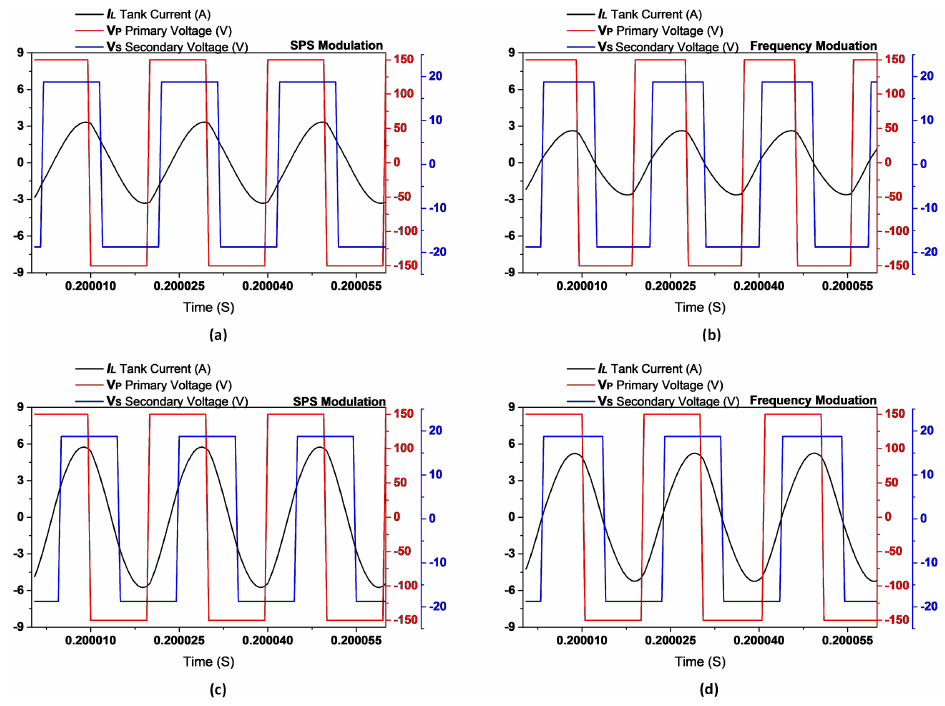
Figure 19. Simulated waveform at a voltage gain of M = 0.5: ( a ) 25% rated power using SPS modulation; ( b ) 25% rated power using frequency modulation; ( c ) 50% rated power using SPS modulation; ( d ) 50% rated power using frequency